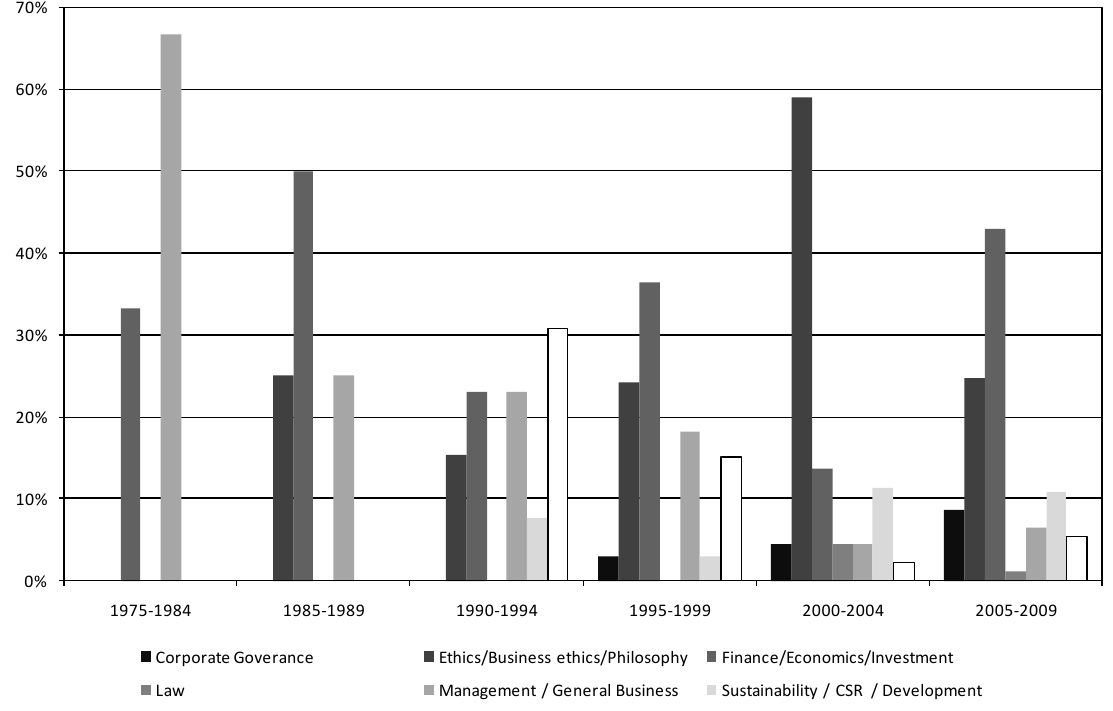
Figure 1: Frequency of papers per discipline over